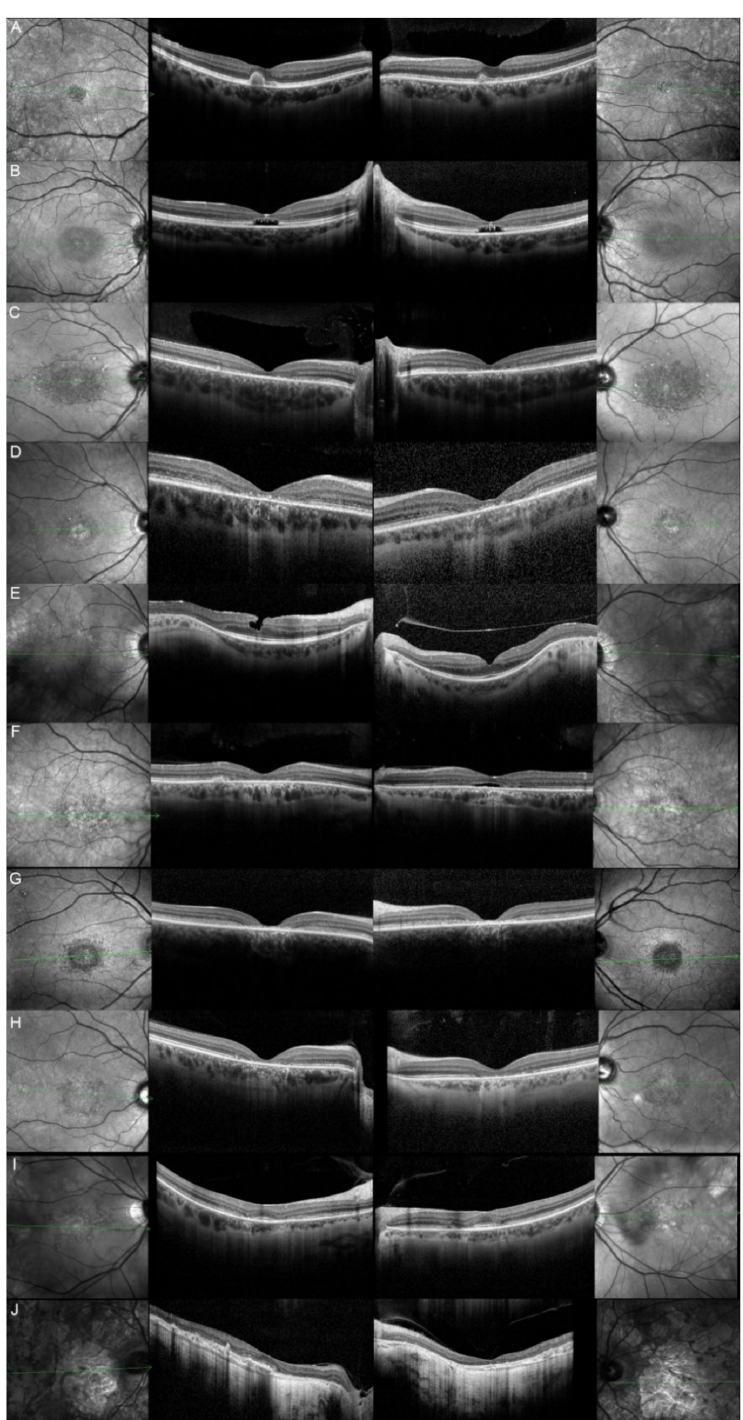
Figure 4. Optical coherence tomography (OCT) of patients harboring pathogenic bi-allelic ABCA4 variants. Patient 1/II.2 ( A ), patient 2/II.1 ( B ), patient 3/II.2 ( C ), patient 4/II.2 ( D ), patient 5/II.2 ( E ), patient 6/II.2 ( F ), patient 7/II.1 ( G ), patient 9/II.2 ( H ), patient 10/I.2 ( I ), and patient 11/III.1 ( J ). For each patient, green lines on FAF images indicate the scanning sections (left and right panels) of the OCT (middle panels). The left panels show the right eye, and the right panels the left one. The OCT findings are described in detail in Table